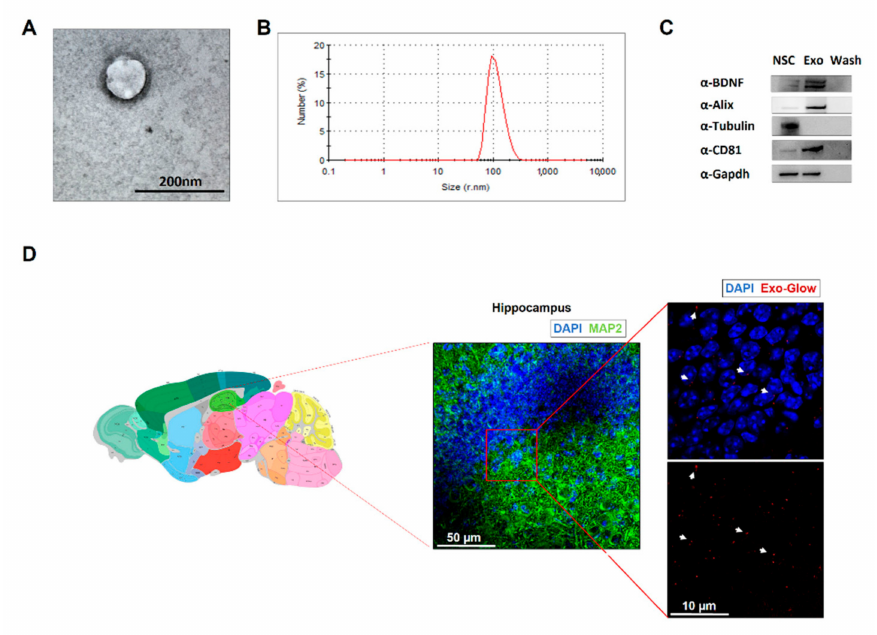
Figure 3. Neural stem cell (NSC)-derived exosomes characterization. ( A ) Transmission electron microscopy image of exosome isolated from NSC medium (exo-NSC). ( B ) Dynamic light scattering spectrum showing the size distribution curve of exo-NSC. ( C ) Representative images of immunoblots analysis of protein lysates extracted from exo-NSC, NSC or washing solution after exosome isolation (See Materials and Methods). CD81 and Alix are exosomal markers whereas Tubulin is used as negative control. ( D ) Confocal images of hippocampus of mice intranasally treated with exo-NSC labelled with fluorescent dye (Exo-Glow, red) and immunofluorescently stained for MAP2 (green). Arrows show exosomal vesicles. Image credit: Allen Institute (http: // mouse.brain-map.org / static / atlas)